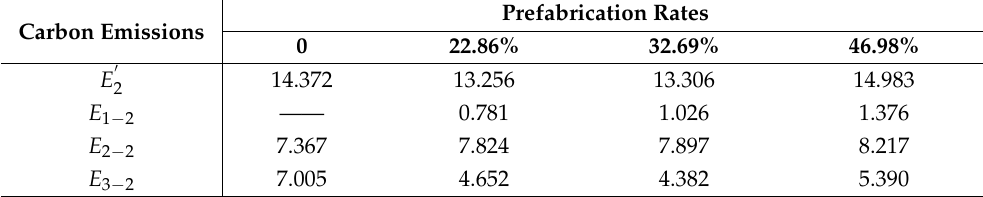
Table 13. Carbon Emissions from Machineries under Different Prefabrication Rates (Unit: kgCO 2 /m 2 ). Carbon